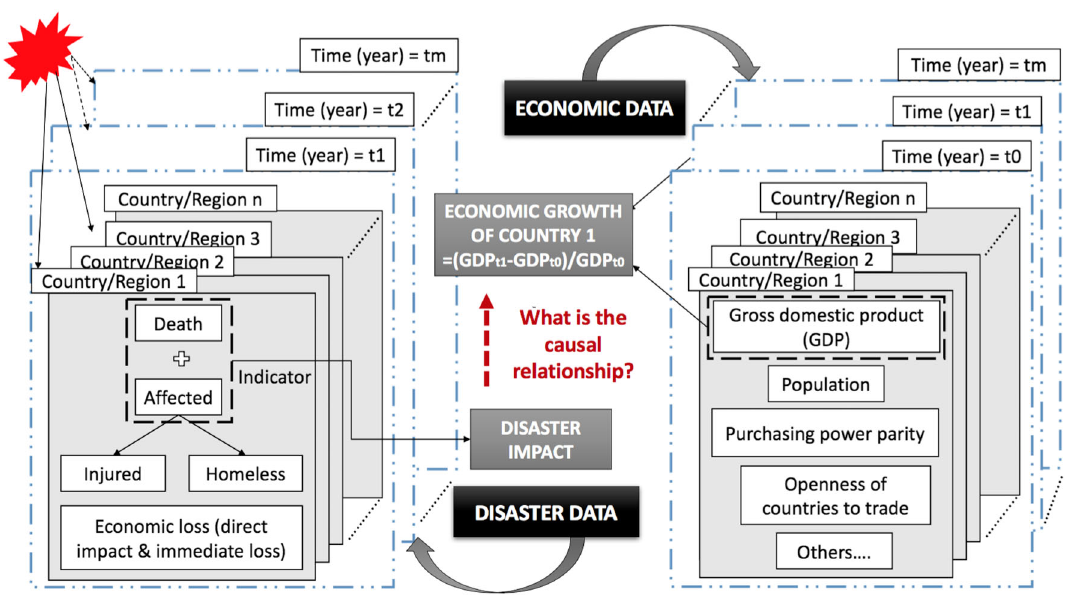
Fig. 1 Methodology and research construct. Source Mukherjee and Hastak